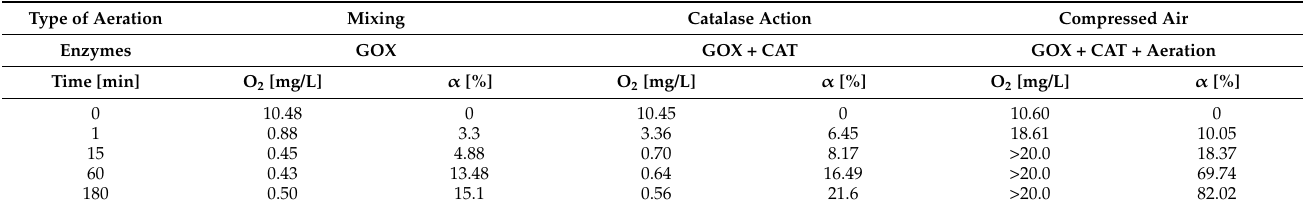
Table 2. The impact of the type of aeration on glucose conversion ( α ) catalyzed by glucose oxidase (glucose 27.5 g/L, native glucose oxidase 0.3 g/L, CAT 1.0 g/L, 0.1 M HEPES buffer pH 6.6, 4 g/L CaCO 3 , 12 ◦ C).